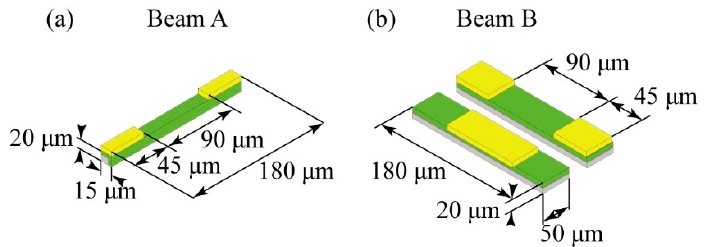
Figure 4. Design and dimensions of the normal stress sensing elements. ( a ) schematic image of the sensing element with piezoresistor on its side wall, ( b ) schematic image of the sensing element with piezoresistor on its surface.